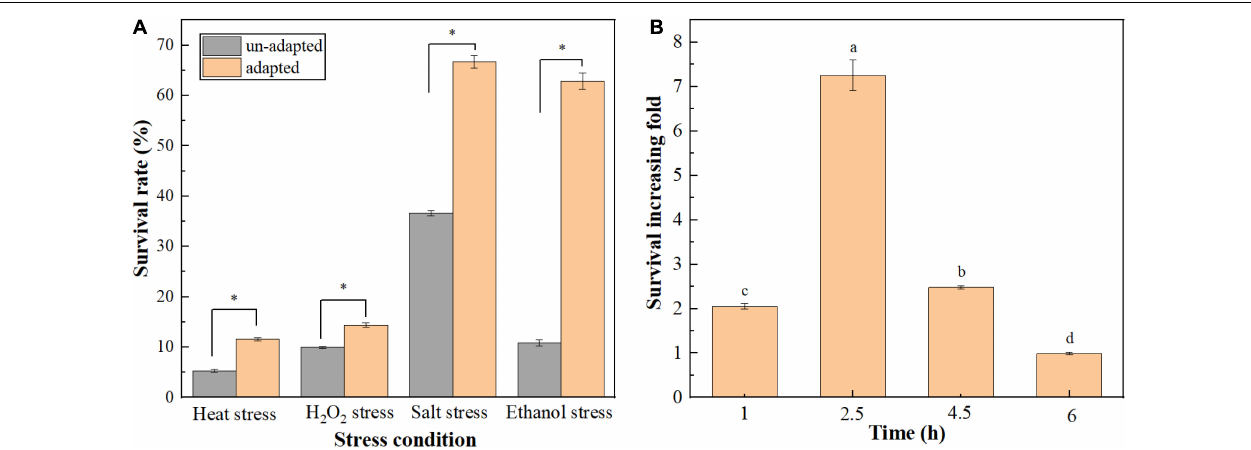
FIGURE 1 | Effect of cross protection on the tolerance of T. halophilus to multiple environmental stresses. (A) Effect of heat preadaptation on the resistance to environmental stresses. Heat preadapted and un-adapted cells were treated by heat stress (60 ◦ C), H 2 O 2 stress (0.03% H 2 O 2 ), salt stress (35% NaCl), and ethanol stress (10% ethanol) for 2.5 h, respectively. (B) Effect of ethanol stress time on the survival increasing fold of T. halophilus during cross protection. Heat preadapted and un-adapted cells were treated by 10% ethanol stress for 1, 2.5, 4.5, and 6 h, respectively, and the survival rates were determined. Error bars indicate SD ( n = 3). Significant differences among the groups are marked with “ ∗ ” or different letters ( p <